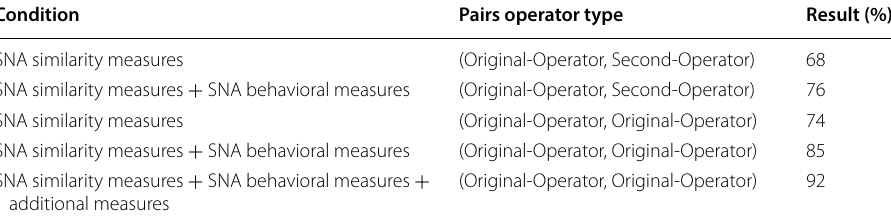
Table 8 Multi-SIM detection model results